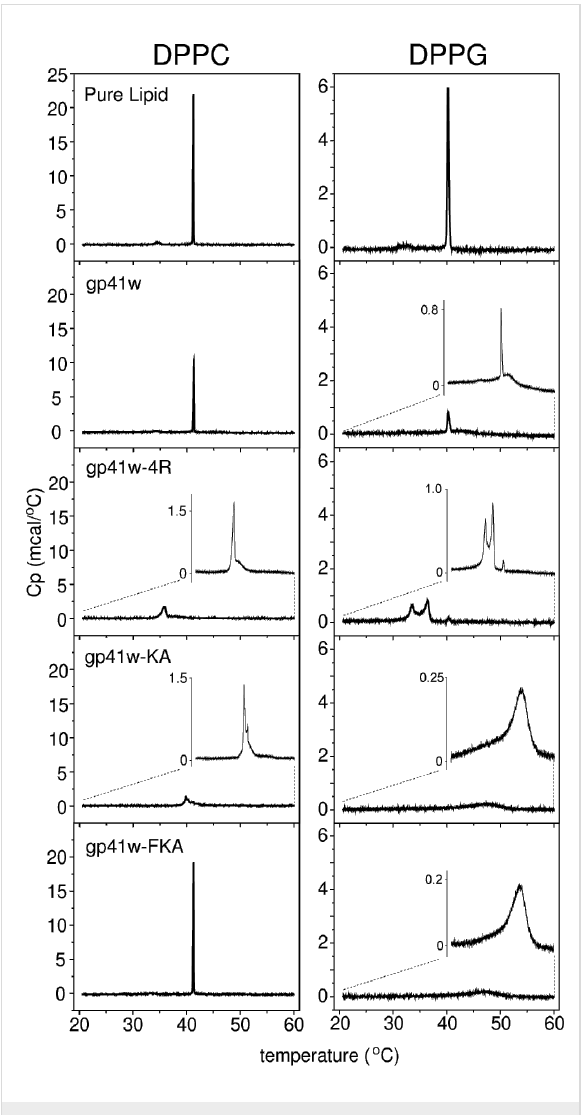
Figure 5: DSC thermograms of pure zwitterionic DPPC (left) and anionic DPPG (right) lipid suspensions compared to lipids mixed with gp41w, gp41w-4R, gp41w-KA and gp41w-FKA. A peptide-to-lipid molar ratio of 1:10 was maintained in all of the samples. The insets are a magnification of the thermogram to show the distribution and shape of the